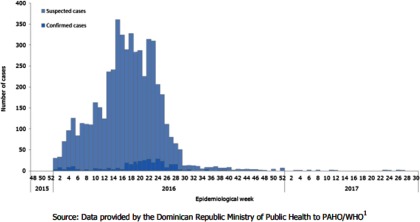
Suspected and Confirmed Zika Virus Cases, Dominican Republic, Epidemiological Week 48 of 2015 to Epidemiological Week 30 of 2017Source: PAHO and WHO (2017).9